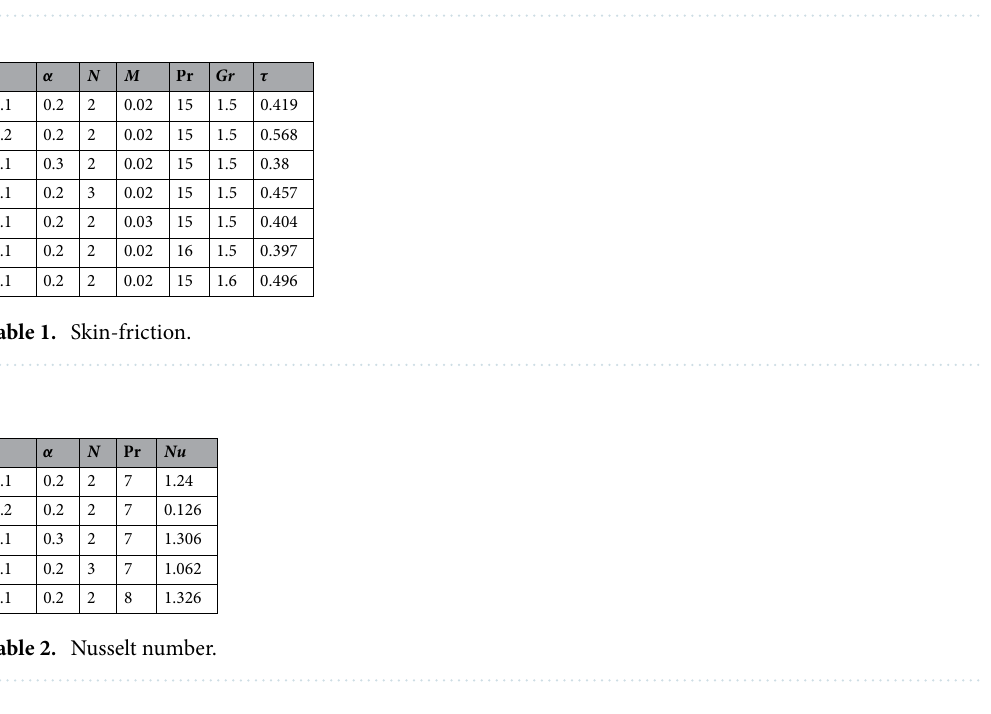
Figure 9. Velocity and temperature profile with comparison of published literature published by Shah & Khan.